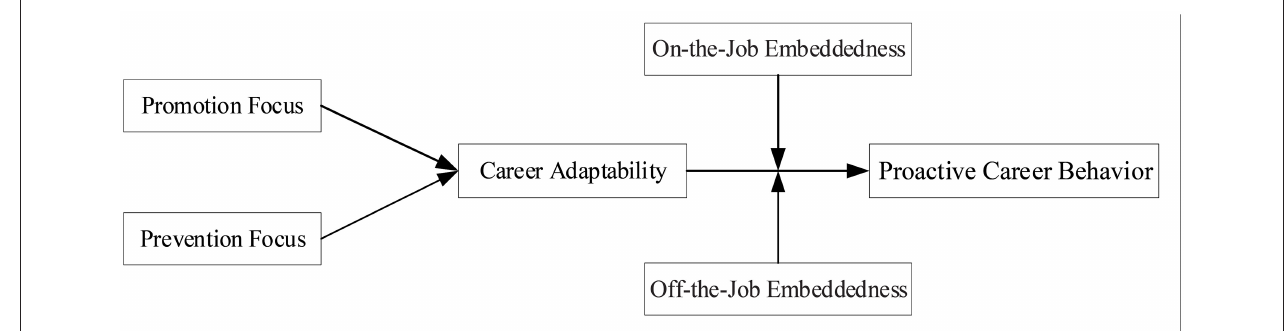
FIGURE 1 | The hypothesized conceptual